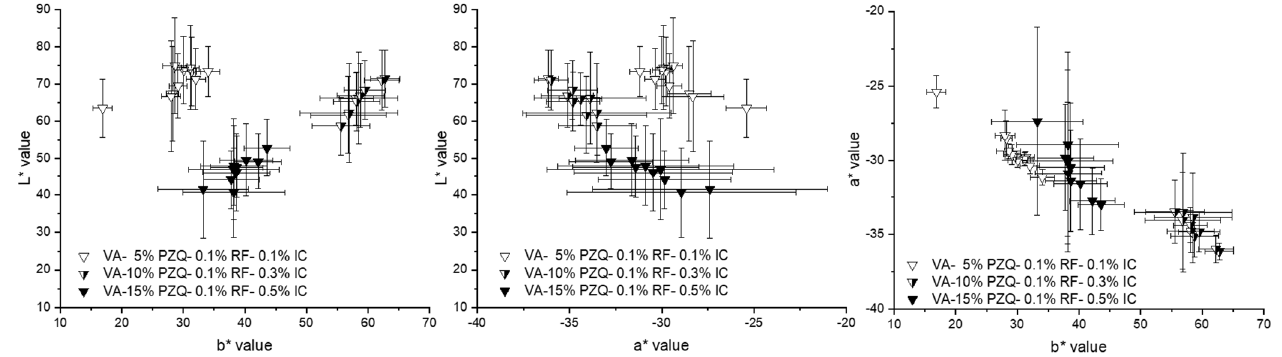
Figure 10. The 2D graphs of L*a*, L*b*, and a*b* values at 2.50 V for color-coded praziquantel filaments (VA-5% PZQ-0.1% RF-0.1% IC, VA-10% PZQ-0.1% RF-0.3% IC and VA-15% PZQ-0.1% RF-0.5% IC).